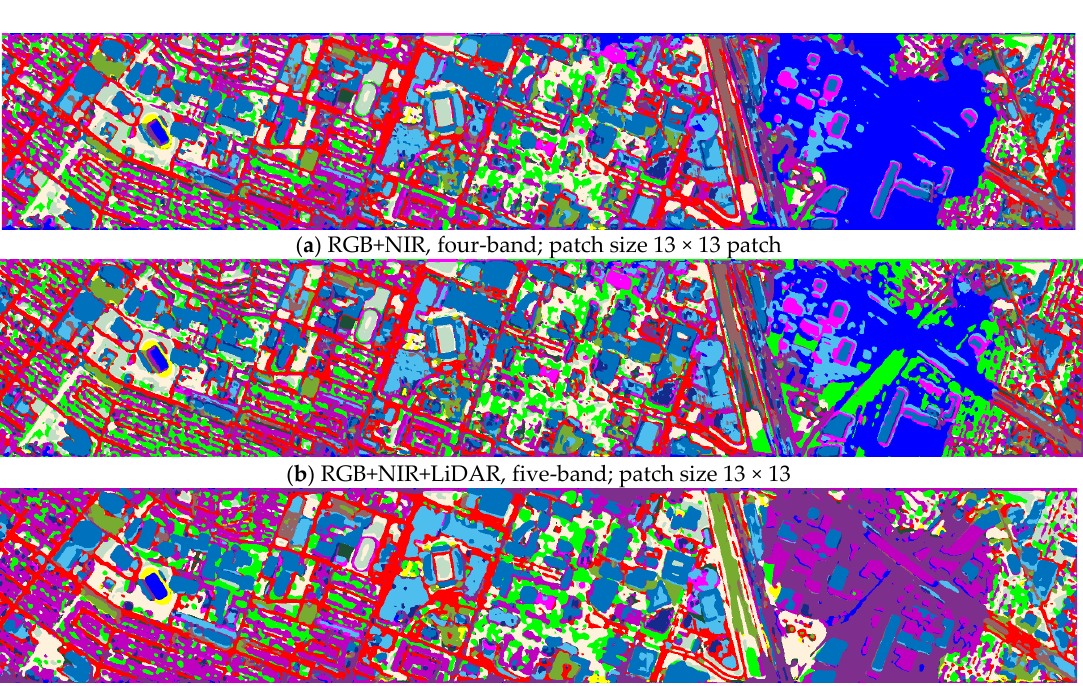
Figure 8. Classification accuracy for each land cover type with CNN-3D model using the investigated band combinations.